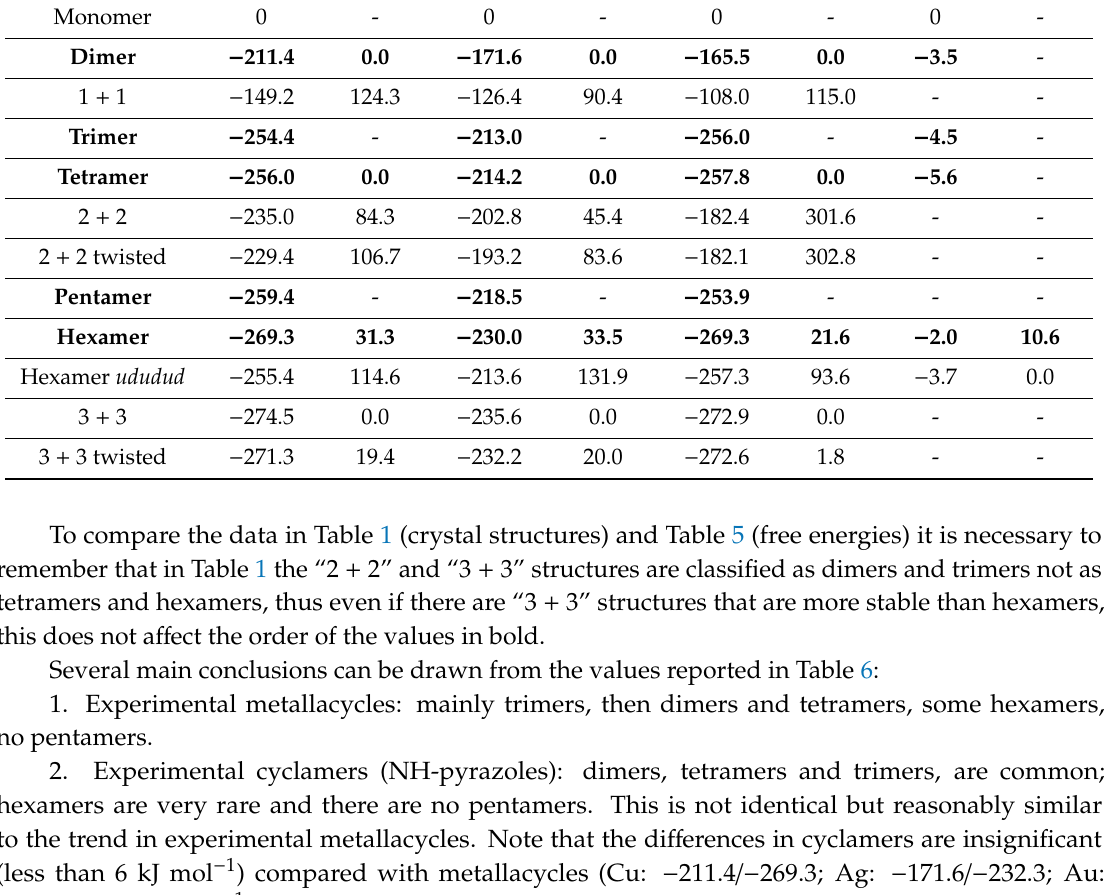
Table 5. δ ∆ G rel = [ ∆ G rel − ∆ G rel (minimum)] × n . The values corresponding to “true” dimers, trimers, tetramers, pentamers and hexamers are marked in bold for comparison with the percentages in Table 1.